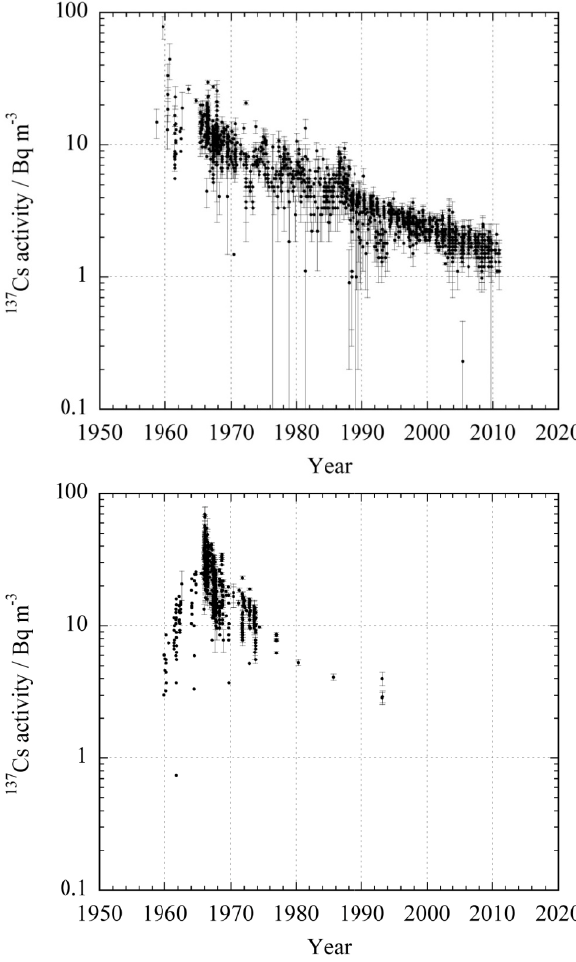
Fig. 1. Long-term changes of 137 Cs concentrations in surface sea- water in two latitudinal belts at 25–40 ◦ N, divided at 180 ◦ E for the western (top) and the eastern (bottom) belt of the North Pacific